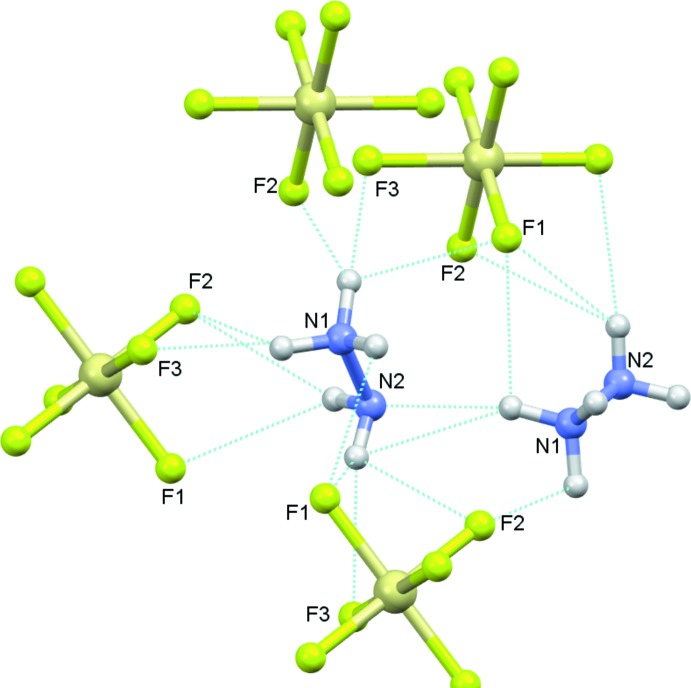
Details of the hydrogen bonds between the hydrazinium (1+) cations and (SiF6)2− anions in (I).